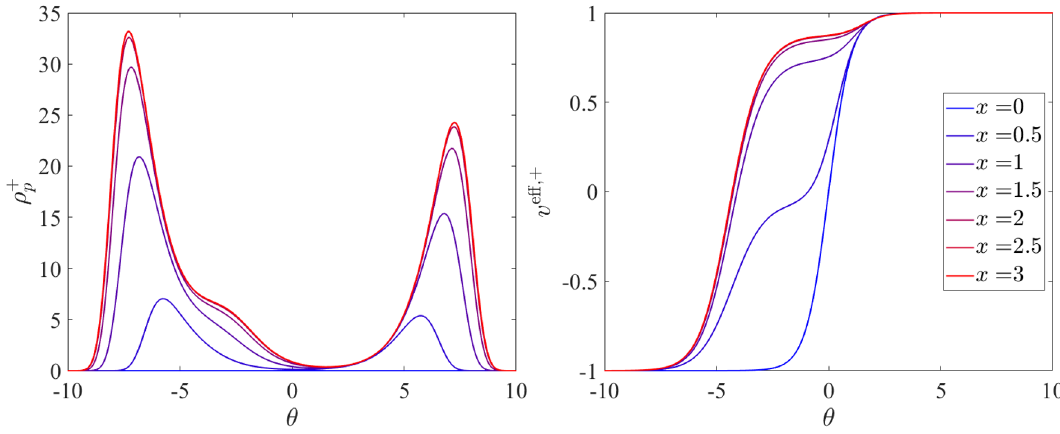
Figure 14 . Cross-sections of the spectral density (left) and effective velocity (right) for the initial condition (5.1) with σ = 10 , log(2 T ) = 7 , T = 0 . The figures are very similar to those presented a m in [24] for the thermal equilibrium case, since for this profile most of the system is at a high temperature T and resembles a Gibbs a